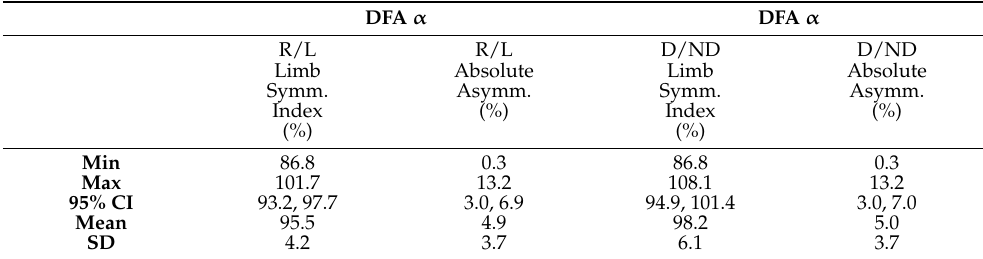
Table 6. Summary statistics for detrended fluctuation analysis α symmetry indices and absolute- asymmetries (n =